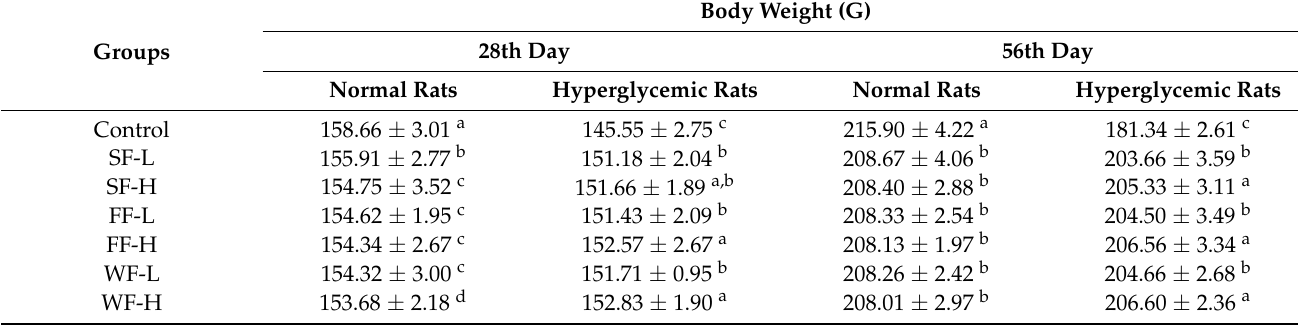
Table 3. Impact of bitter melon supplementation on body weight of rats.